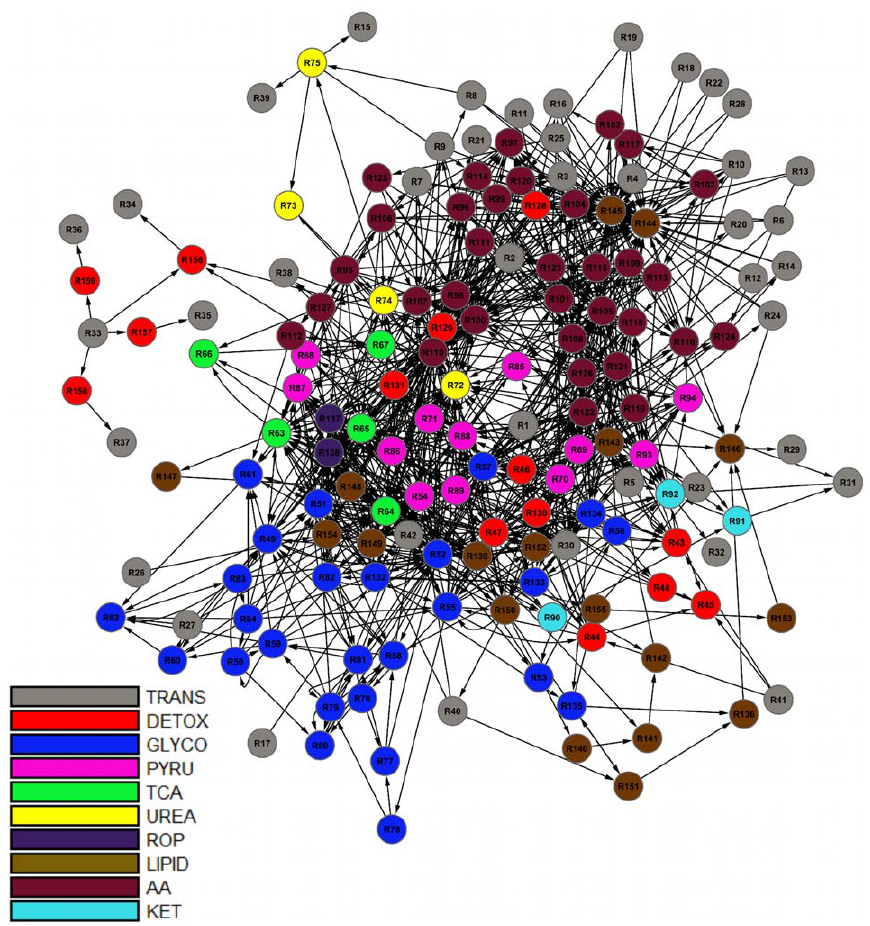
Figure 2. Graph image of the metabolic network. Each reaction in the network was a priori assigned to one of 10 textbook pathways as described in Methods. The pathway assignments are indicated by the color of the reaction vertex in the network. (TRANS: transport; DETOX: detoxification; GLYCO: glucose metabolism; PYRU: pyruvate metabolism; TCA: tca cycle; UREA: urea cycle; ROP: oxidative phosphorylation; LIPID: lipid metabolism; AA: amino acid metabolism; KET: ketone body